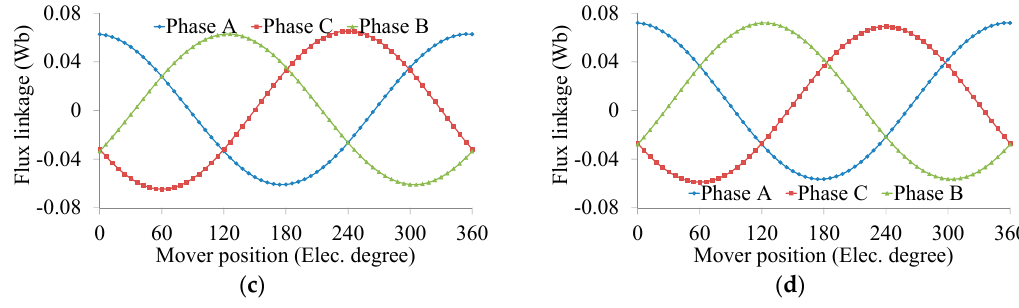
Figure 14. 3-phase no-load flux linkage waveforms. ( a ) Machine I; ( b ) Machine II; ( c ) Machine III; ( d ) Machine IV.